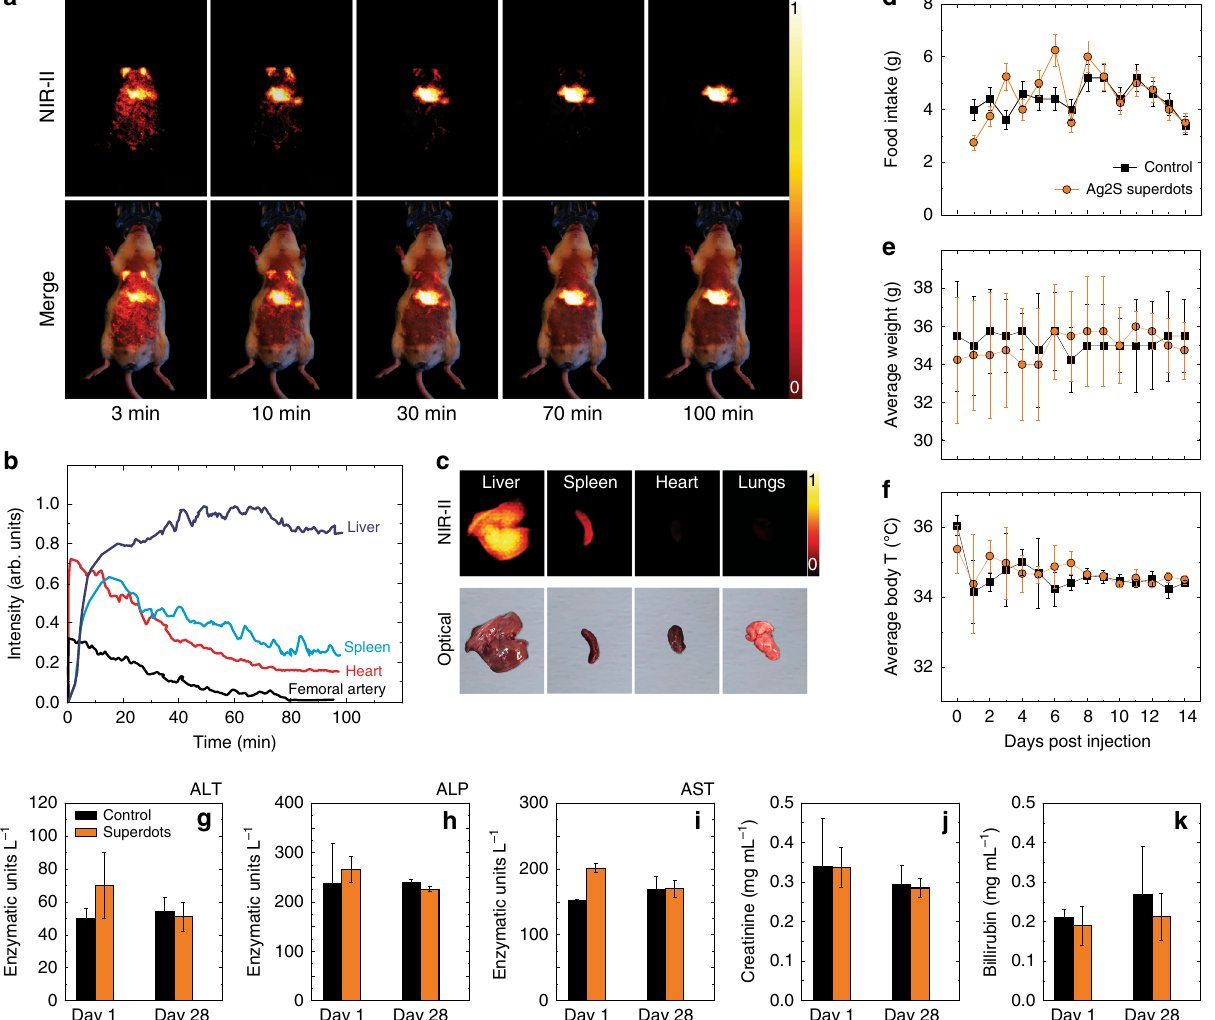
Fig. 5 In vivo time-resolved imaging with Ag 2 S superdots. a NIR-II fl uorescence images obtained at different times after intravenous injection of Ag 2 S superdots dispersed in PBS (100 µ L, 0.15 mg mL − 1 ). b Time evolution of the fl uorescence intensity at the liver, spleen, heart, and femoral artery after intravenous injection of Ag 2 S superdots. c NIR-II ex vivo fl uorescence and optical images of the liver, spleen, heart, and lungs obtained from a mouse euthanized 100 min after intravenous injection of Ag 2 S superdots. Time evolution of daily food intake ( d ), weight ( e ), and body temperature ( f ) of four CD1 mice after intravenous injection of 300 μ L of a dispersion of Ag 2 S superdots in PBS (0.5 mg mL − 1 , total dose of 150 μ g). The results obtained from a control group intravenously injected with 300 μ L of PBS are included for comparison. Serum concentration ( g ) of hepatic enzymes ( g , h and i ) for mice intravenously injected with Ag 2 S superdots and control mice as obtained 1 and 28 days after injection. Serum concentration of creatinine ( j ) and bilirubin ( k ) corresponding to mice subjected to an intravenous injection of Ag 2 S superdots and control mice as obtained 1 and 28 days after injection. ( n = 3 for each group). The error bars correspond to the standard error of the mean